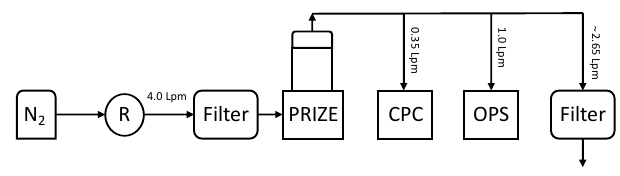
Figure 3. Schematic of the experimental setup used in this study. A filtered dry nitrogen flow was controlled by a rotameter (R) up- stream of PRIZE. Downstream, the flow was split into three parts to a CPC, an OPS and excess flow discarded through a